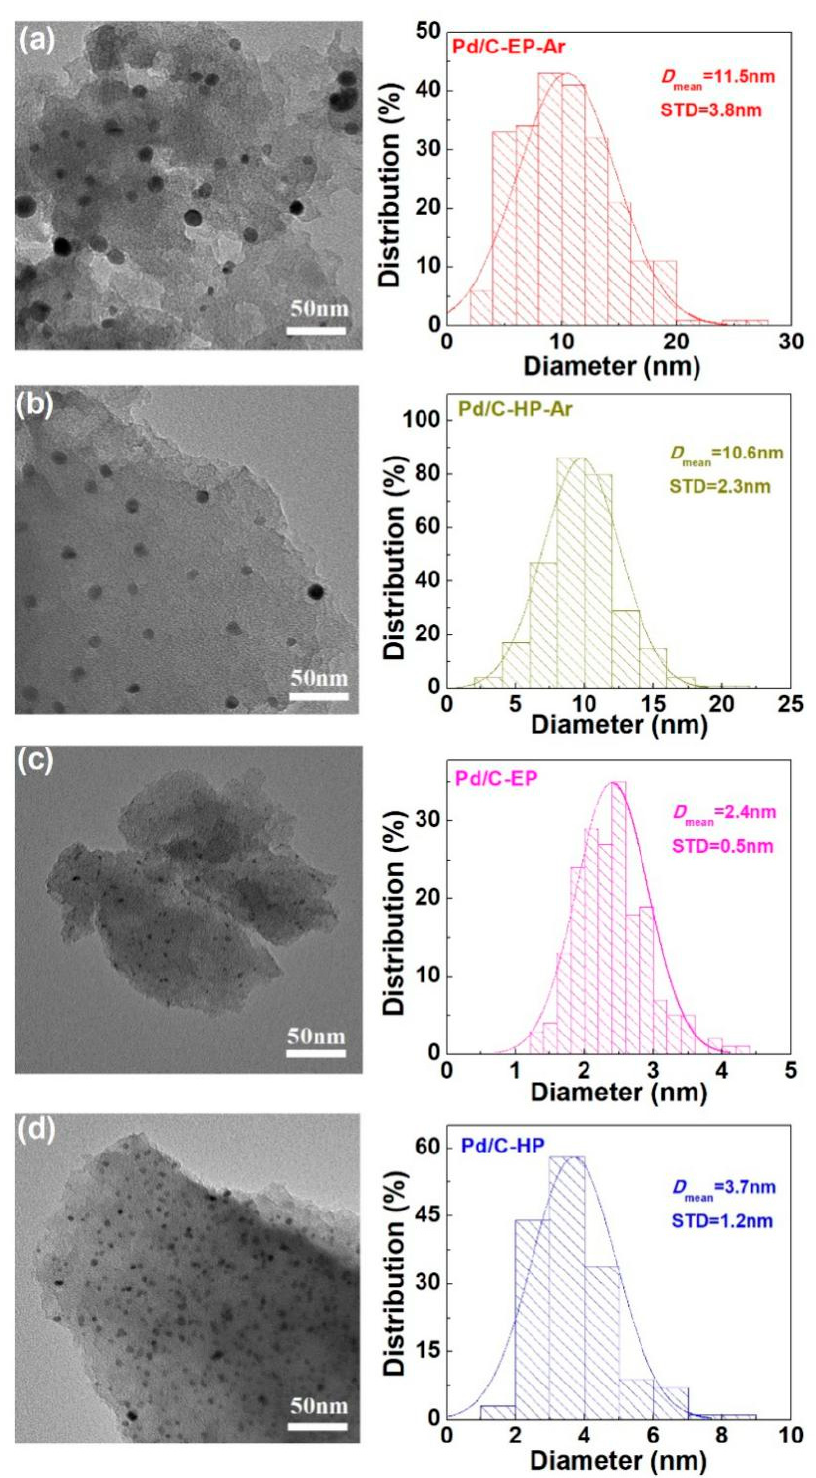
Figure 6. Typical transmission electron microscopy (TEM) images of ( a ) Pd / C-EP-Ar, ( b ) Pd / C-HP-Ar, ( c ) Pd / C-EP, and ( d ) Pd / C-HP and the corresponding histograms of the size distribution of the Pd nanoparticles.